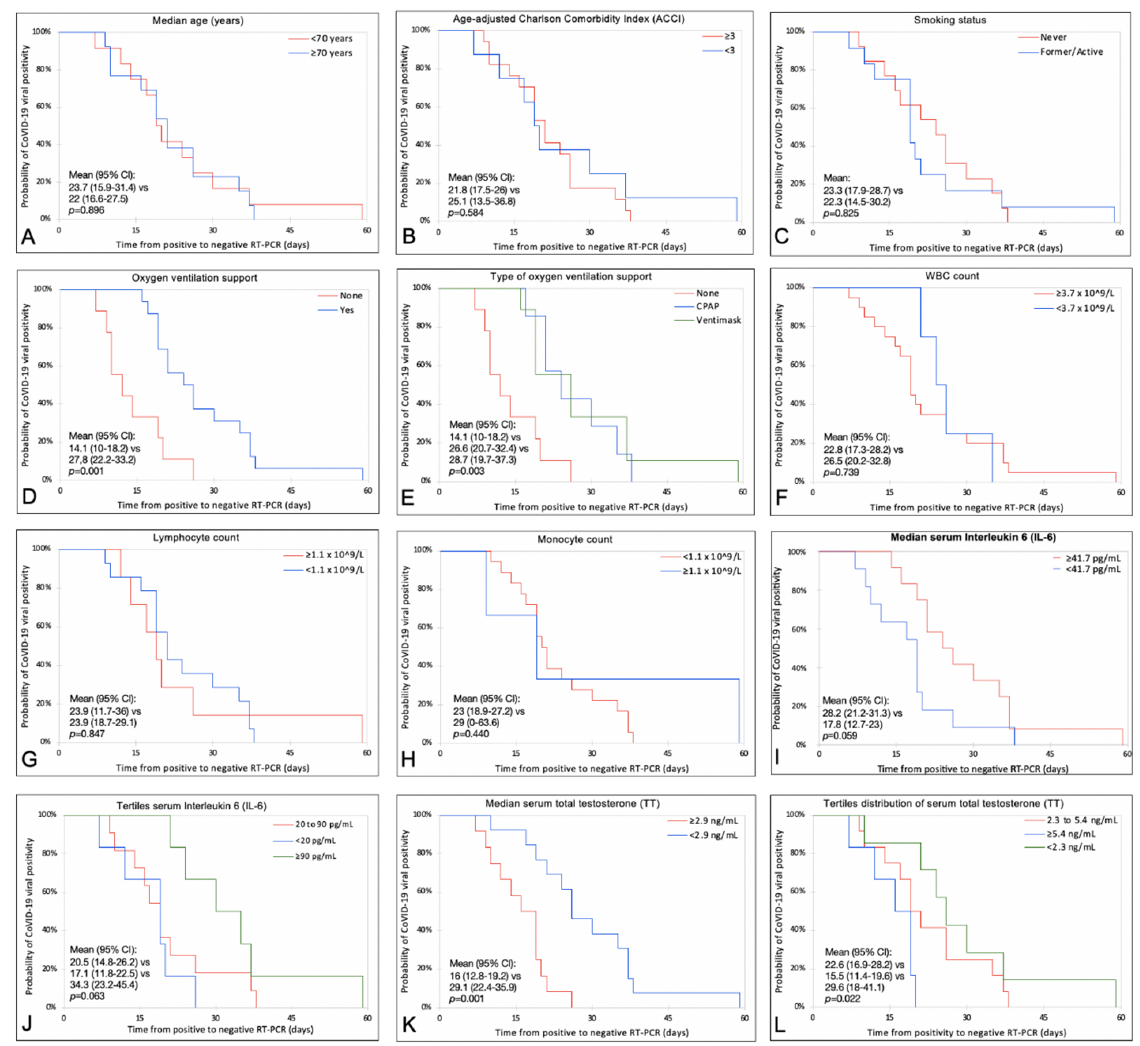
Figure 1. Kaplan–Meier estimates and Log-rank test to explore differences between clinical variables for the duration of COVID-19 viral positivity. Comparisons between: ( A ) = patient age groups; ( B ) = ACCI groups; ( C ) = smoking status; ( D ) = oxygen ventilation support; ( E ) = type of oxygen ventilation; ( F ) = WBC count; ( G ) = lymphocyte count; ( H ) = monocyte count; ( I ) = IL-6; ( J ) = tertiles distribution of IL-6; ( K ) = serum TT; ( L ) = tertiles distribution of TT. ACCI: Age-Adjusted Charlson Comorbidity Index; WBC: white blood cell; IL-6: interleukin 6; TT: total testosterone.